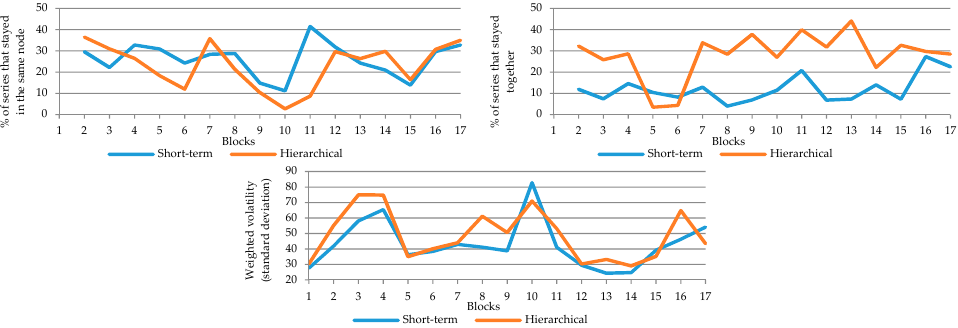
Figure A8. Detailed results for 𝑚𝑖𝑛𝑆𝑒𝑟𝑖𝑒𝑠 set at 5% and window length 𝑤 set at 30 days for hierarchical clustering.